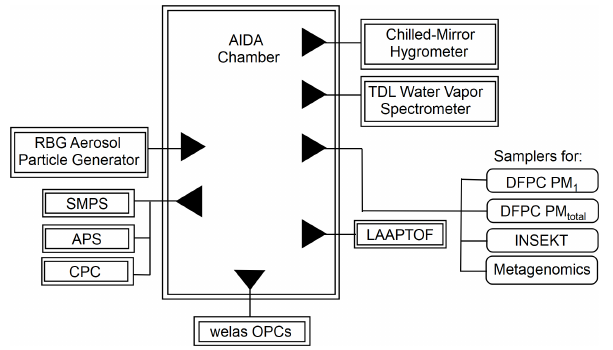
Figure 1. Lab experimental schematic of the AIDA facility. All samples were injected using a rotating brush generator (RBG) for aerosol particle generation. Multiple extramural instruments, welas optical particle counters (OPCs), a hygrometer, a tunable diode laser (TDL) spectrometer, a laser ablation aerosol particle time-of-flight mass spectrometer (LAAPTOF; see Supplement), and aerosol parti- cle counters/sizers (SMPS, APS, CPCs) are connected to the AIDA chamber. Downstream filters and impactors collected aerosol parti- cles for multiple offline